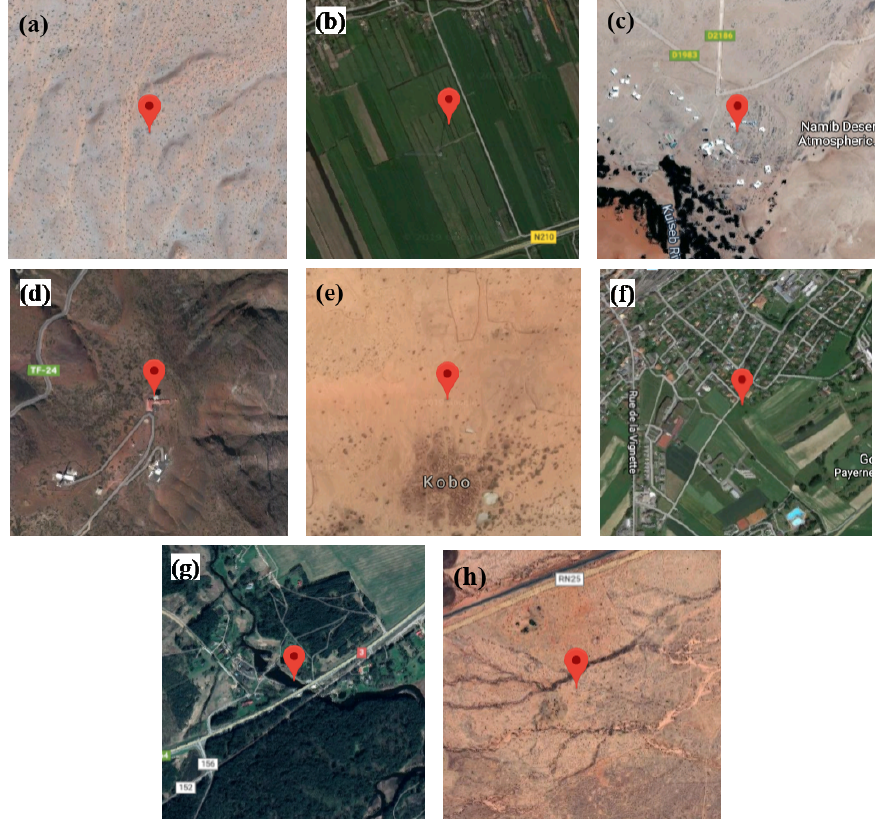
Figure 2. The 1 km × 1 km boxes for the eight BSRN and AMMA sites, as extracted from Google maps: ( a ) Agoufou; ( b ) Cabauw; ( c ) Gobabeb; ( d ) Izana; ( e ) Kobou; ( f ) Payerne; ( g ) Toravere; and ( h ) Wankama flux sud. Information about their location and period of operation are given in Table